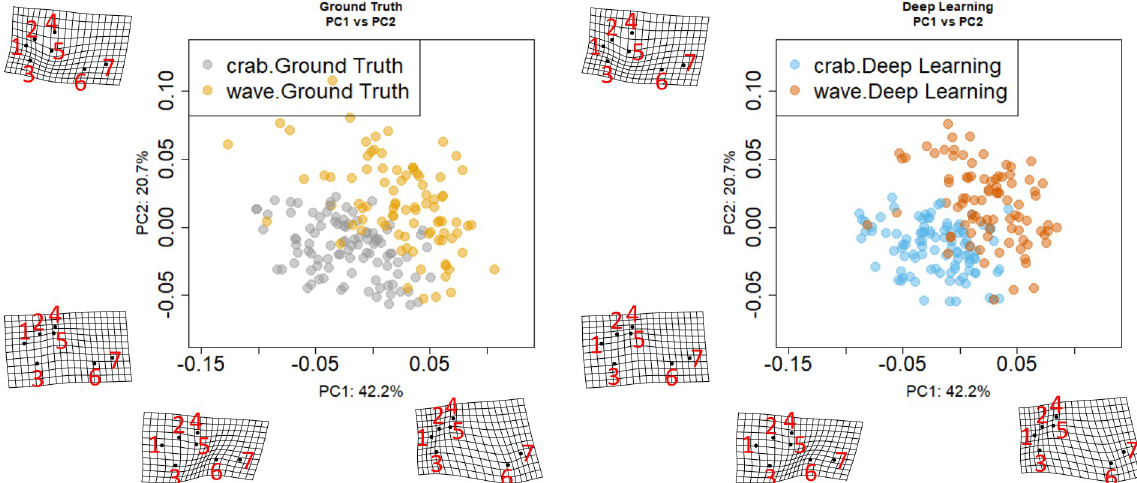
Fig 8. Distributions of PC1 and 2 for Littorina shells. PC1 and PC2 explains 62.9% of the total variation. Left: the ground truth landmarks (Crab: Grey; Wave: Yellow). Right: Deep Learning predicted landmarks (Crab: Blue; Wave: